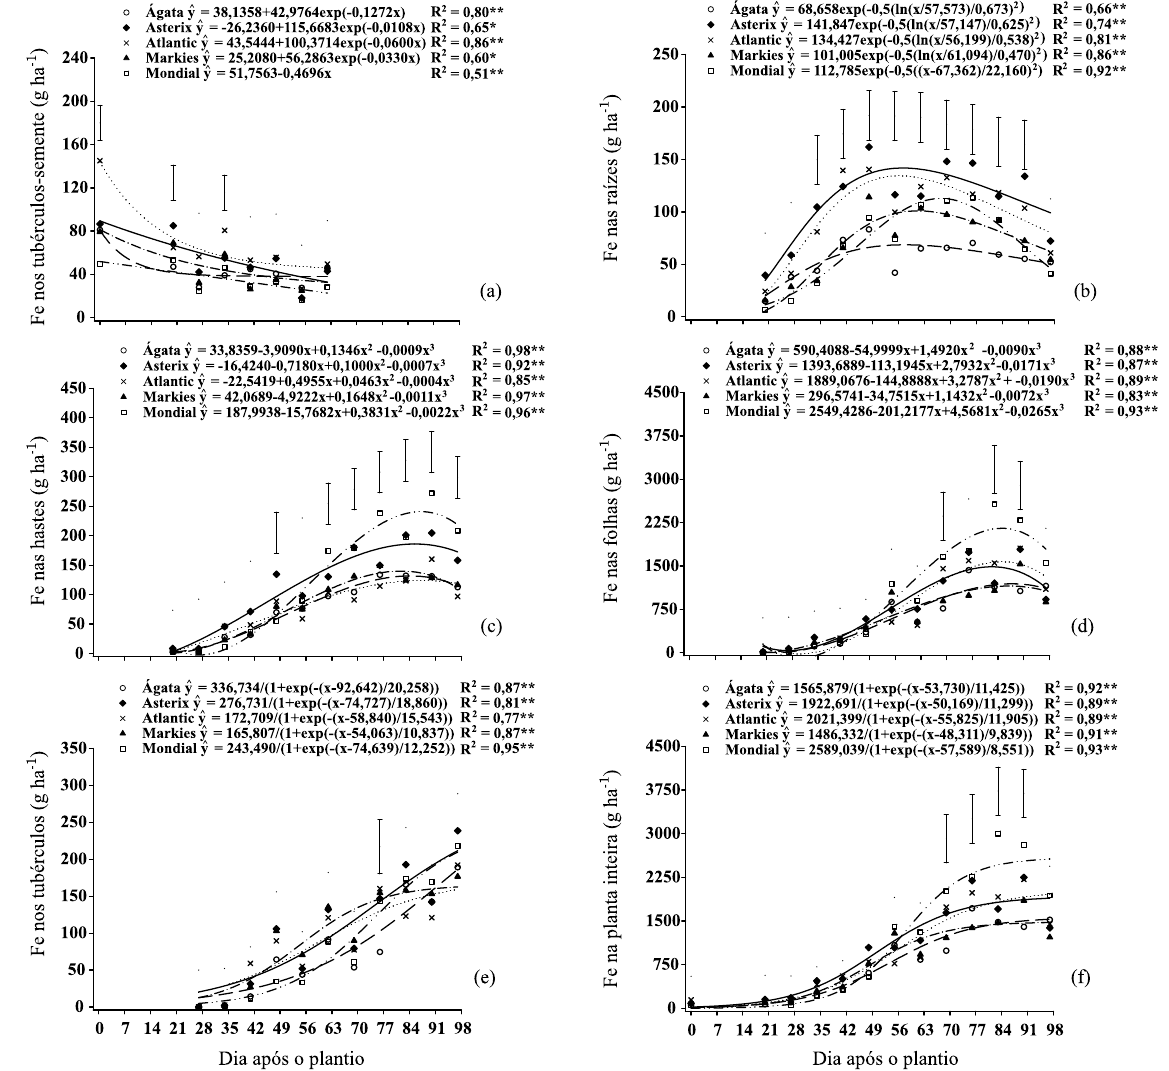
Figura 4. Quantidade de Fe nos tubérculos-semente (a), raízes (b), hastes (c), folhas (d), tubérculos (e) e na planta inteira (f) de cultivares de batata ao longo do ciclo. * e **: significativos a 5 e 1 % pelo teste F. Barras verticais indicam o valor de DMS pelo teste de Tukey a 5